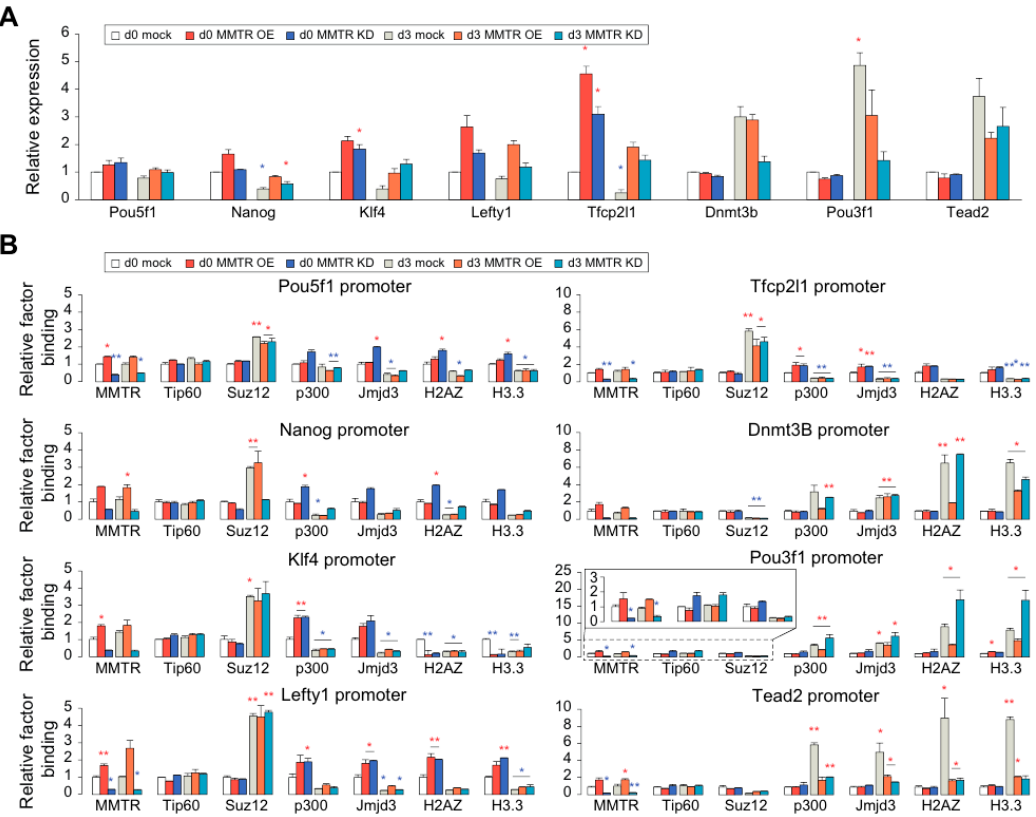
Figure 6. mESC commitment gene expression is differentially regulated by both MMTR/Dmap1 and Suz12 during mESCs differentiation. ( A ) RT-qPCR graphs showing selected mESC commitment genes expression in undifferentiated (d0) and differentiated (d3) MMTR OE and KD mESCs. We obtained expression levels of samples in each gene by RT-qPCR and depicted the relative folds to the d0 mock values. ( B ) ChIP-qPCR showing the relative binding of transcription control factors to the promoters of mESC commitment genes. Binding folds normalized by IgG values and relative folds were depicted to the d0 mock values. n = 2. * p < 0.05; ** p < 0.01.